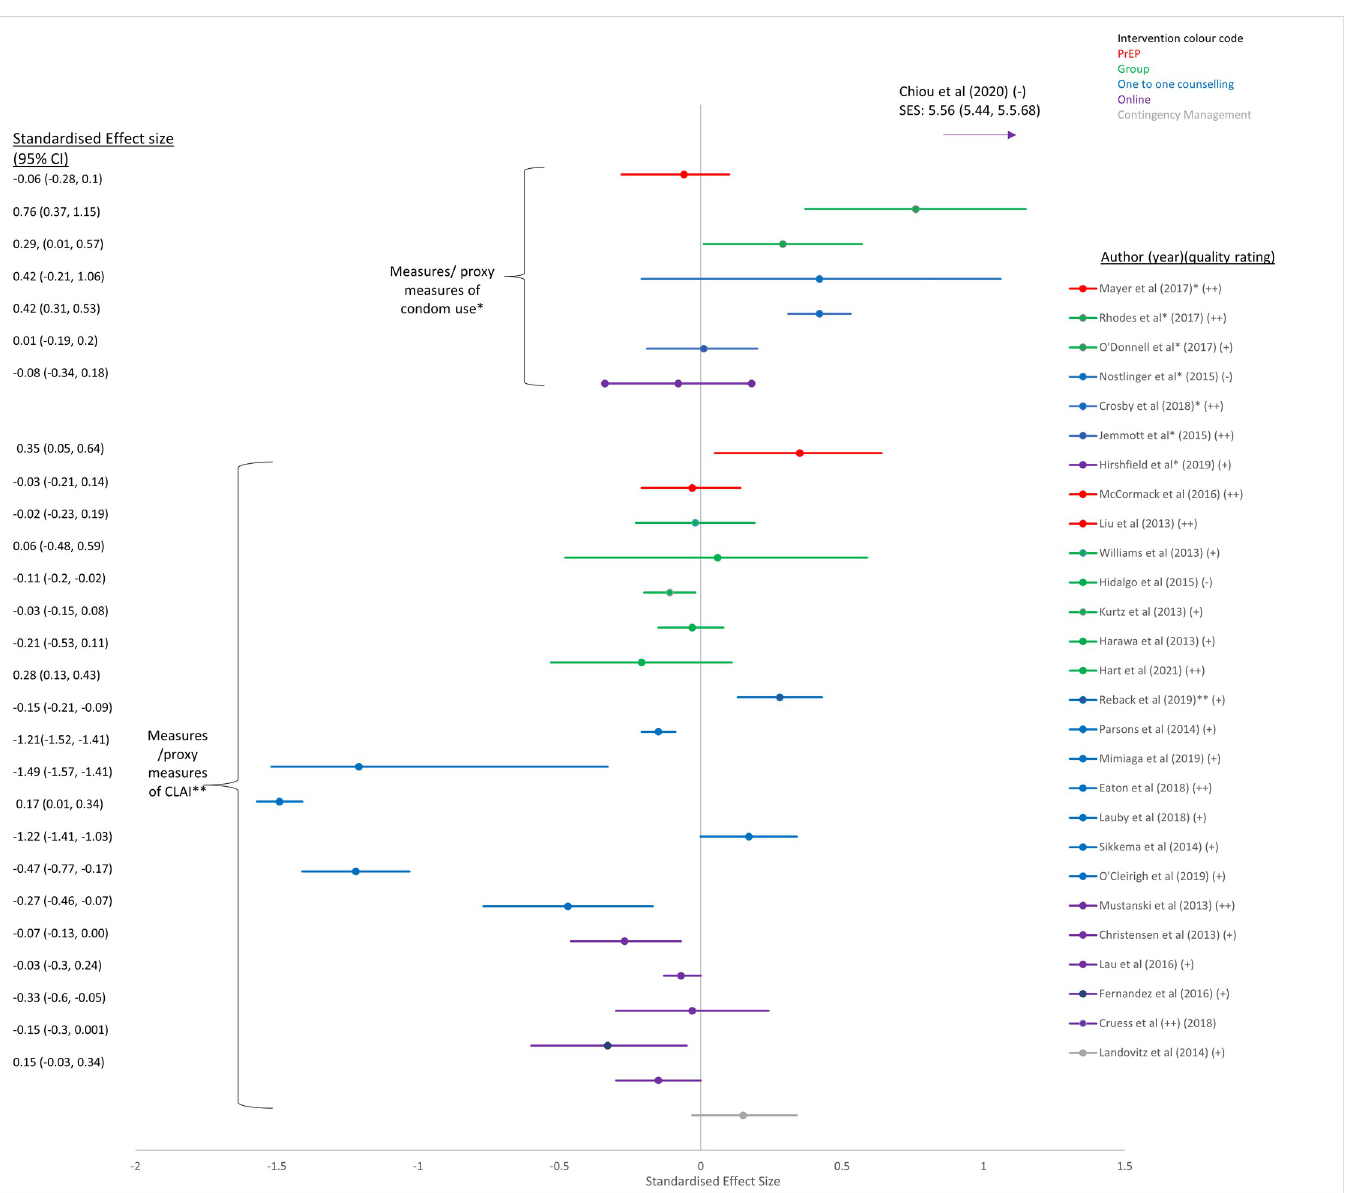
Fig 4. Intervention effect on measures of CLAI or condom use. � outcome reported as a measure of condom use–positive values reflect a desirable outcome �� outcome reported as a measure of CLAI–negative values reflect a desirable